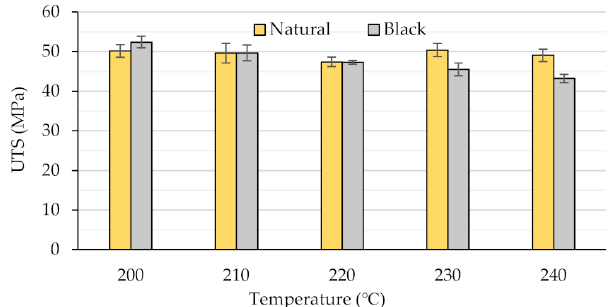
Figure 2. The variation of the ultimate tensile strength (UTS) with the printing temperature and the filament